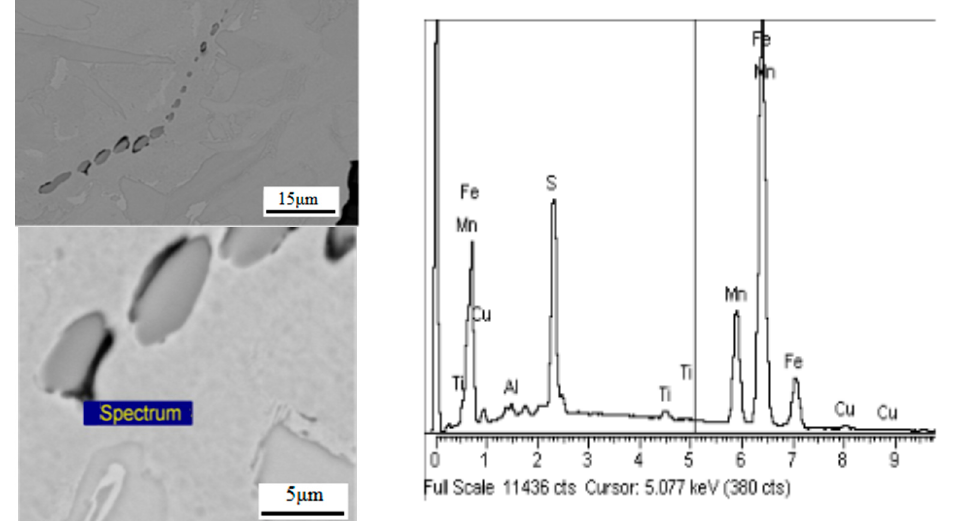
Figure 5. Line of MnS inclusions situated at pre-existing austenite grain boundaries, which have a high Cu rich rim (black areas) round the periphery of the manganese sulphide inclusions, Steel 2 (0.5% Cu) tested at 800 °C.